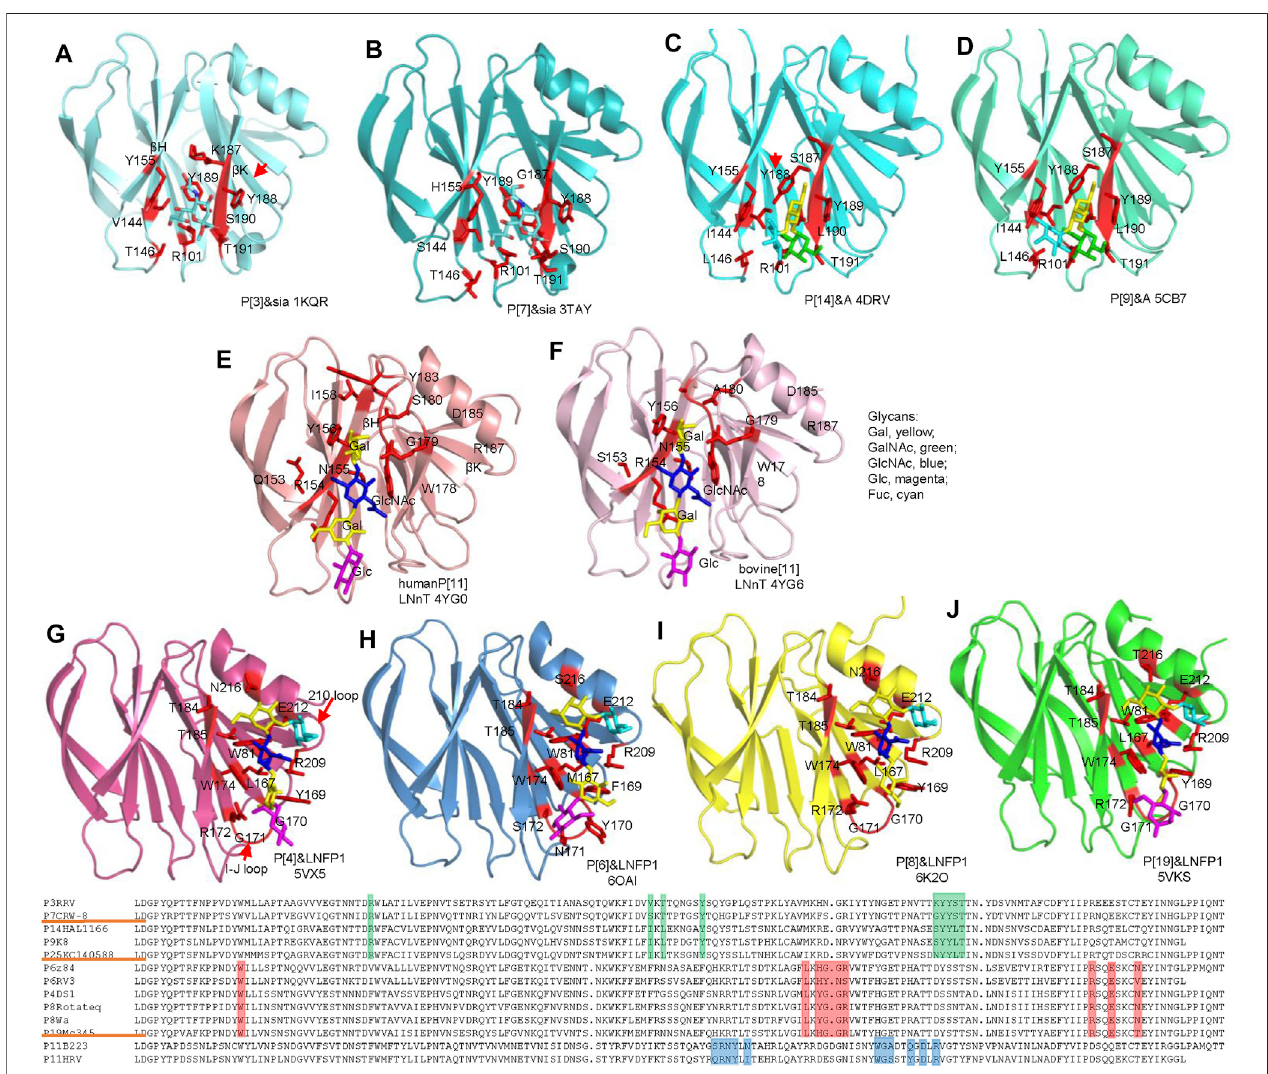
FIGURE4| StructuralanalysisofdifferentRVVP8*sincomplexwithglycans.VP8*sareshownascartoonpresentation.Glycansandaminoacidsparticipatingthe interactions are exhibited as sticks. RRV P[3] (A) , CRW-8 P[7] (B) , HAL1166 P[14] (C) , K8 P[9] (D) , human P[11] (E) , bovine P[11] (F) , P[4] Indian (G) , RV-3 P[6] (H) , RotateqP[8] (I) ,humanP[19] (J) ,VP8*sarecoloredasthatin Figure.2A .ThemoietiesofGal,GalNAc,GlcNAc,Glc,Fucarecoloredyellow,green,blue,magenta,cyan, respectively. Sequence alignment was done by DNAMAN. The residues involved in the glycan binding in P[3]/P[7]/P[14]/P[9], P[4]/P[6]/P[8]/P[19], P[11] VP8*s are colored green, red, blue, respectively.